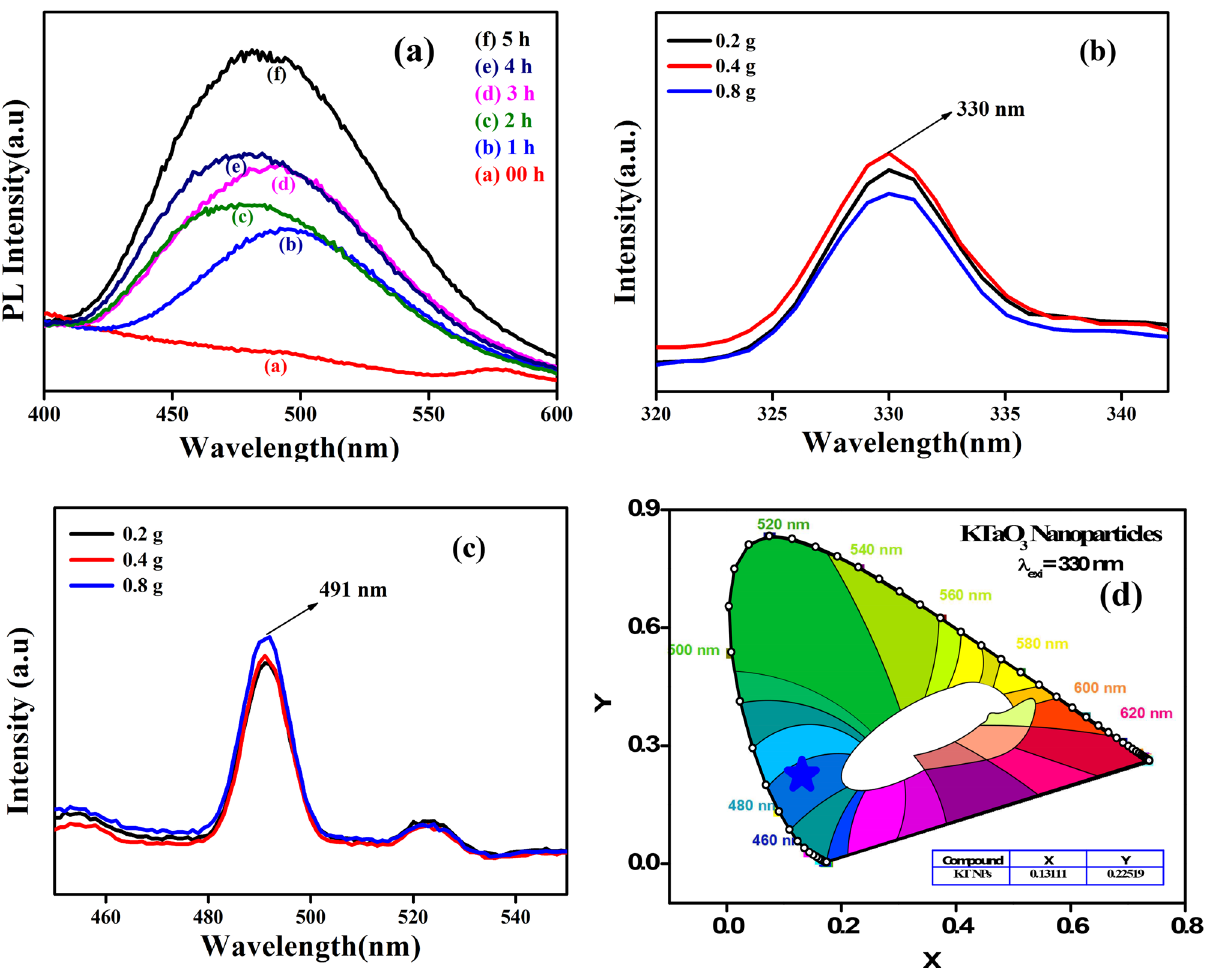
Figure 9. ( a ) PL spectra showing the presence of large amount of OH radicals by forming 7-hydroxyl coumarin from coumarin upon increasing the time. ( b ) PL excitation peak ( c ) emission peak ( d ) CIE diagram showing the emission of blue colour of 3D-F-KT NPs prepared by different concentrations of areca seed